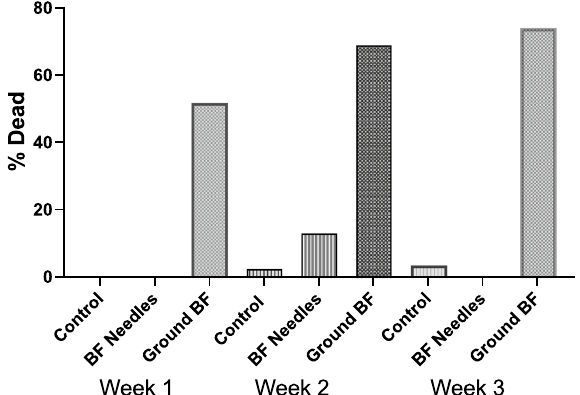
Figure 1. Effect of intact and ground balsam fir needles on the survival of adult female Ixodes scapularis exposed to 0–4 °C. N = 27 ticks/group for Week 1 and Week 3. For Week 2, N = 36 for controls and N = 45 for